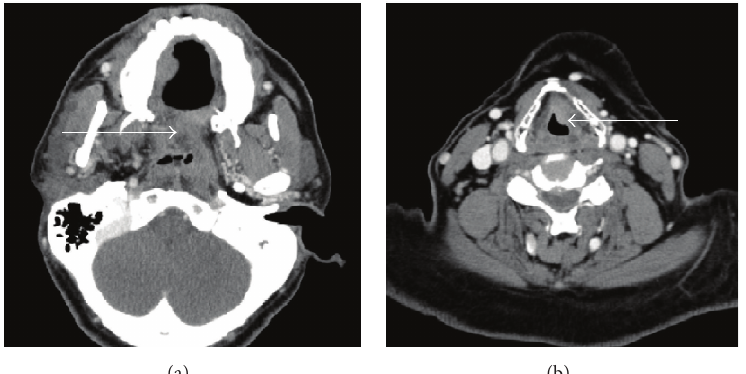
Figure 2: (a) 21 × 24 × 25 mm mass involving the soft palate significantly narrowing the nasopharynx. (b) 15 × 9mm lesion along the anterior aspect of the left false vocal cord.